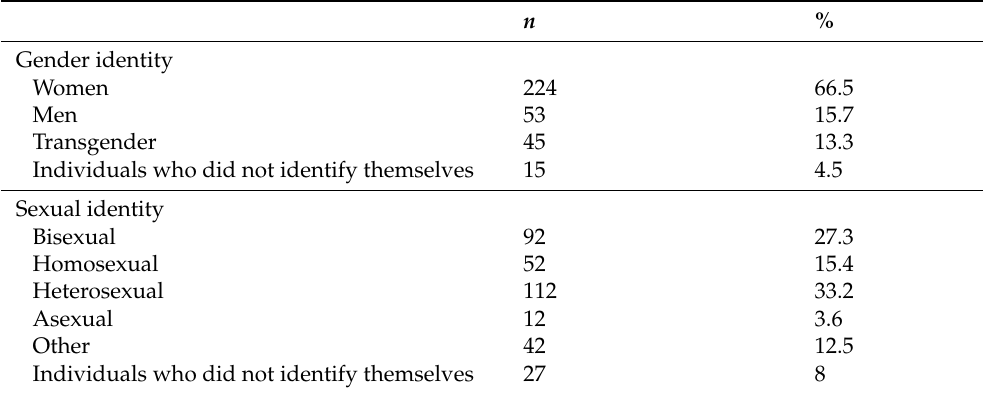
Table 1. Characteristics of the respondents in terms of gender and sexual identity. n